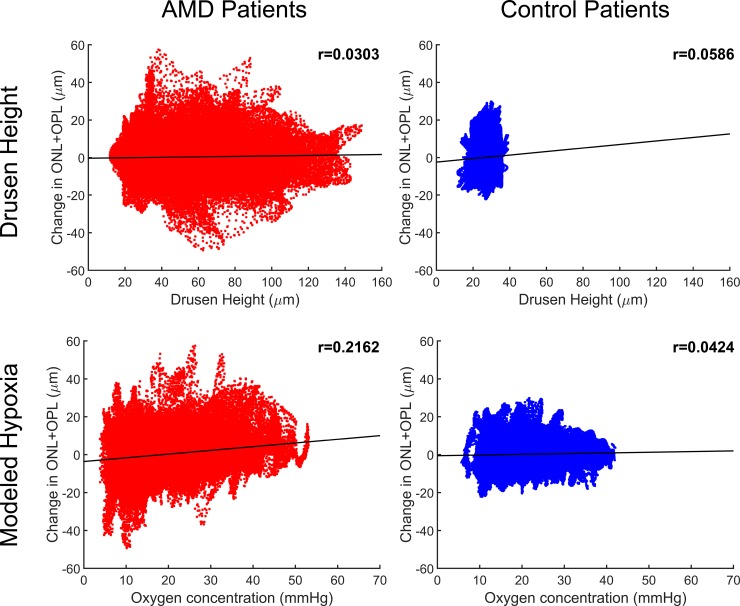
Correlation between future retinal thinning and drusen height (row 1) or modeled steady-state oxygen levels (row 2) at the same retinal location.The y-axis represents the change in ONL and OPL thickness between the initial and follow-up time point with negative values representing thinning of the ONL + OPL. Column 1 shows data from 15 AMD patients and Column 2 shows data from 6 control subjects (n = 22,500 data points per patient from a 150 x 150 value spatial map). The correlation between drusen height (i.e. BrM-drusen-RPE thickness) and future retinal thinning is positive–opposite of what might be expected—but rather weak for both groups (r = 0.0303 for AMD, r = 0.0652 for controls). The correlation between steady-state oxygen concentration and retinal thinning was much stronger for AMD patients (r = 0.2162) suggesting that the model may be able to better predict future retinal degeneration than drusen dimensions because of its ability to incorporate additional factors such as drusen width and previous retinal thinning.